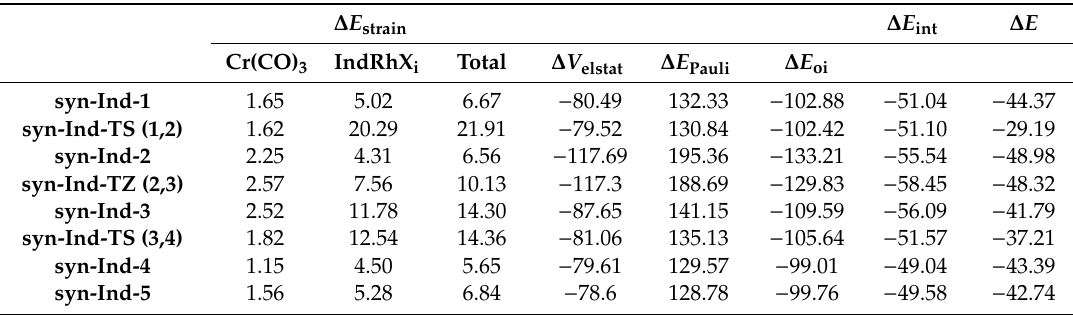
Table 4. Activation strain analysis (ASA) of all the intermediates and transition states along the syn-IndRh catalyzed cycle (Path I); all the values are in kcal mol − 1 . The fragments are Cr(CO) 3 and IndRhX i.